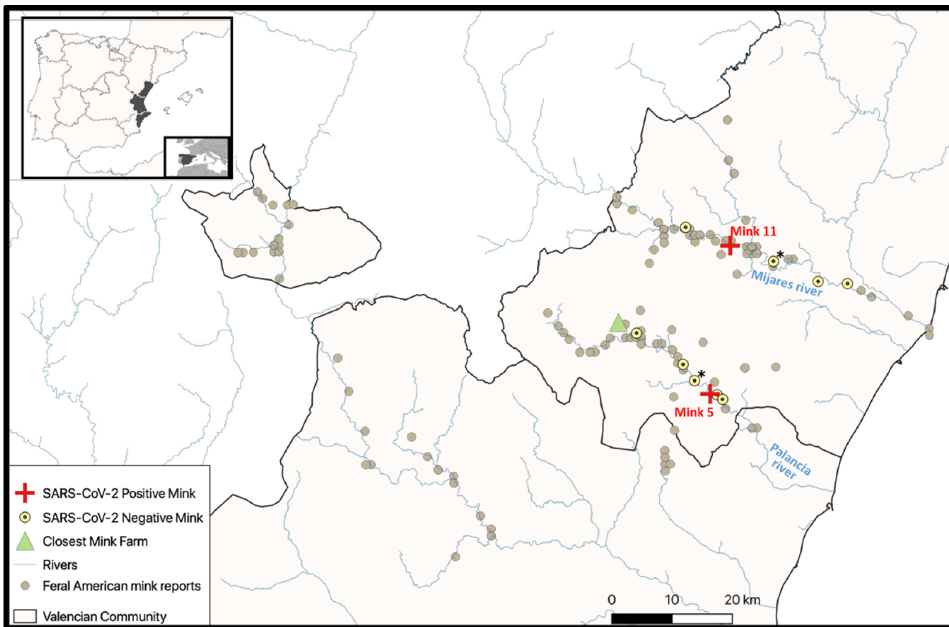
Figure 1. Study area. Feral American mink reports (1987–2016 [34]), trapping sites, and the closest fur farm are shown. (*) Indicates a trapping site where two of the present SARS-CoV-2-negative specimens were captured (then sharing the same UTM coordinates). Other symbols are shown in the key to the figure inset.